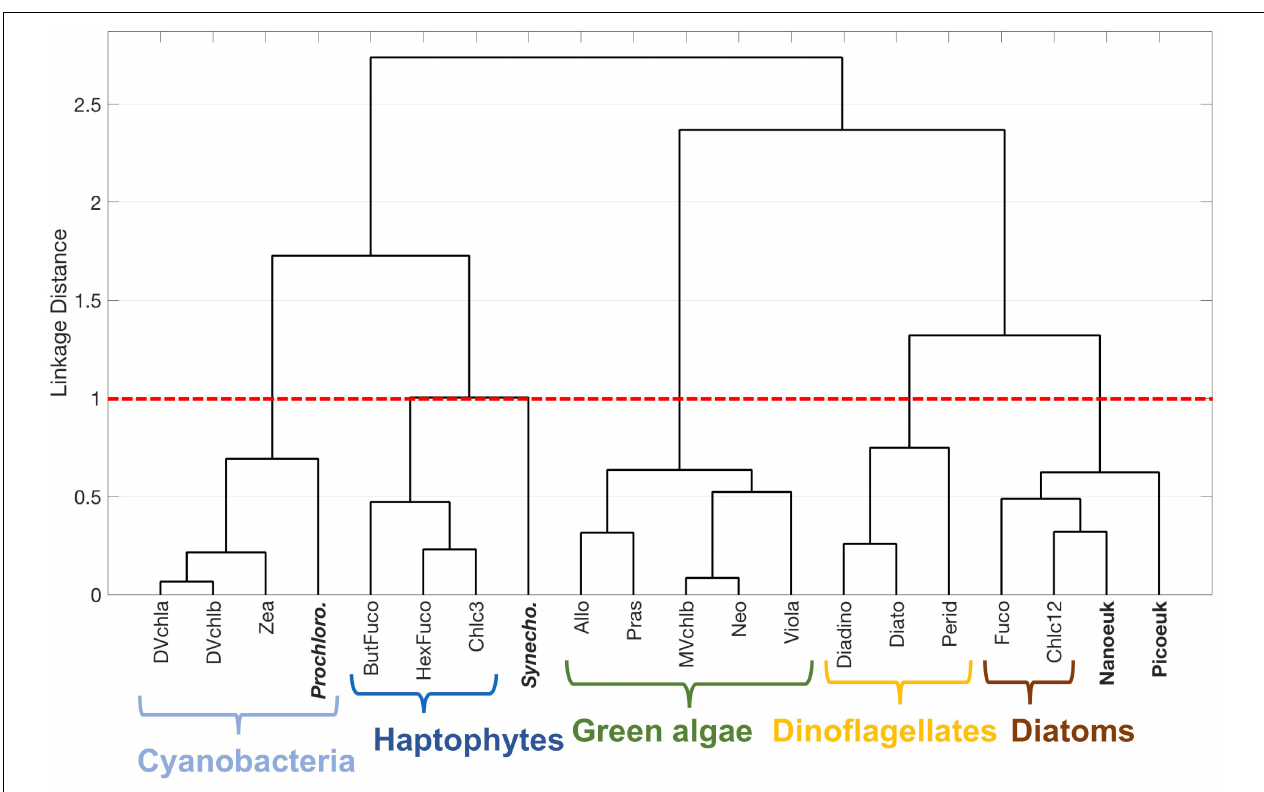
FIGURE 9 | Hierarchical clustering of phytoplankton pigment ratios to total chlorophyll- a concentration and flow cytometry group cell counts to total cell counts. Five major phytoplankton pigment groups (cyanobacteria, haptophytes, green algae, diatoms, and dinoflagellates) are delineated with